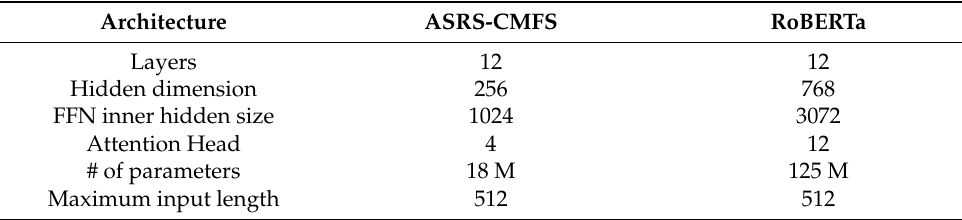
Table 7. Comparison of the architecture of the two models.